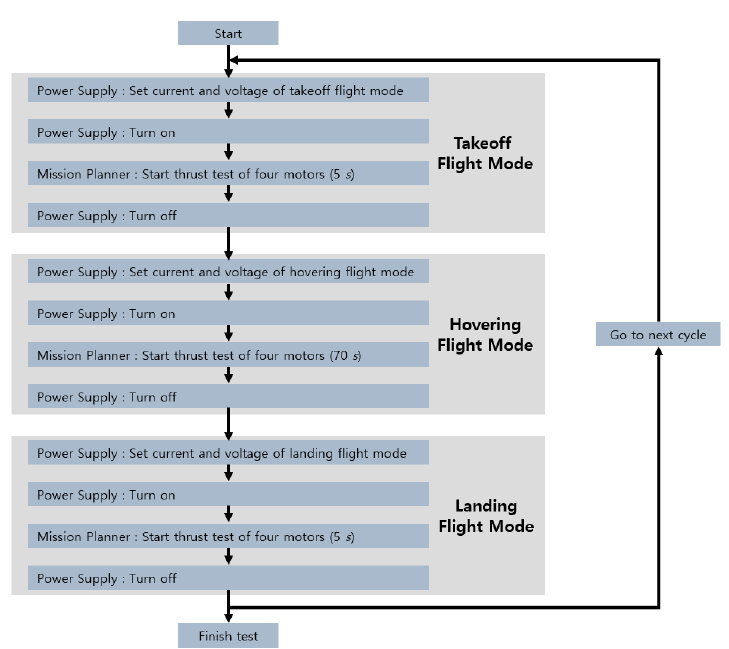
Figure 10. Experimental procedure.